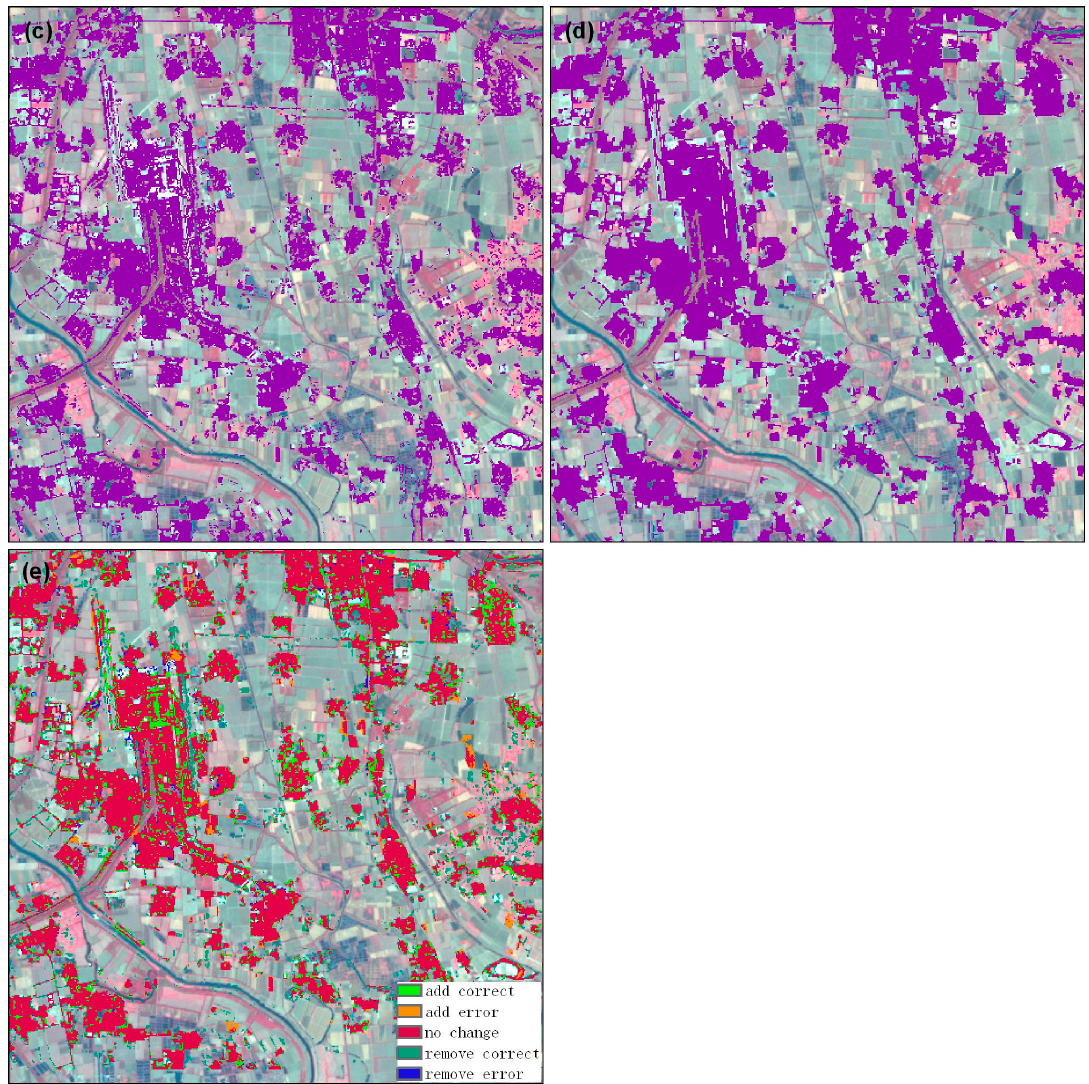
Figure 5. Objects that were segmented by the mean shift method and the refined impervious surface after synthesizing the object and SVM results: ( a ) ETM+ sub-image at Path 123/Row 032 that was acquired on 21 October 1999; ( b ) boundaries of objects that were segmented by the mean shift method (yellow lines); ( c ) impervious surface that was classified by the SVM classifier; ( d ) refined impervious surface based on the integration of the segmented objects and the SVM classification result; and ( e ) detailed information regarding the integration.